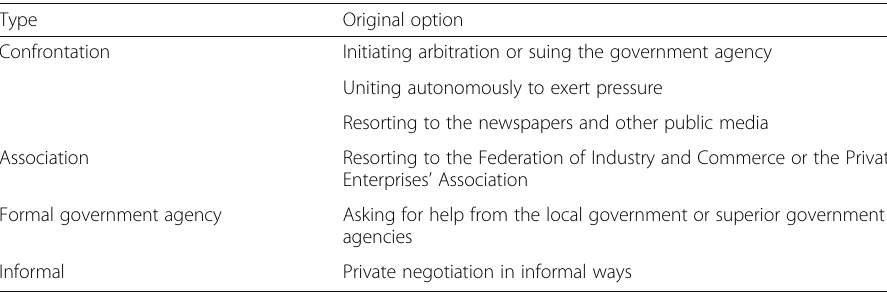
Table 1 Four types of strategies